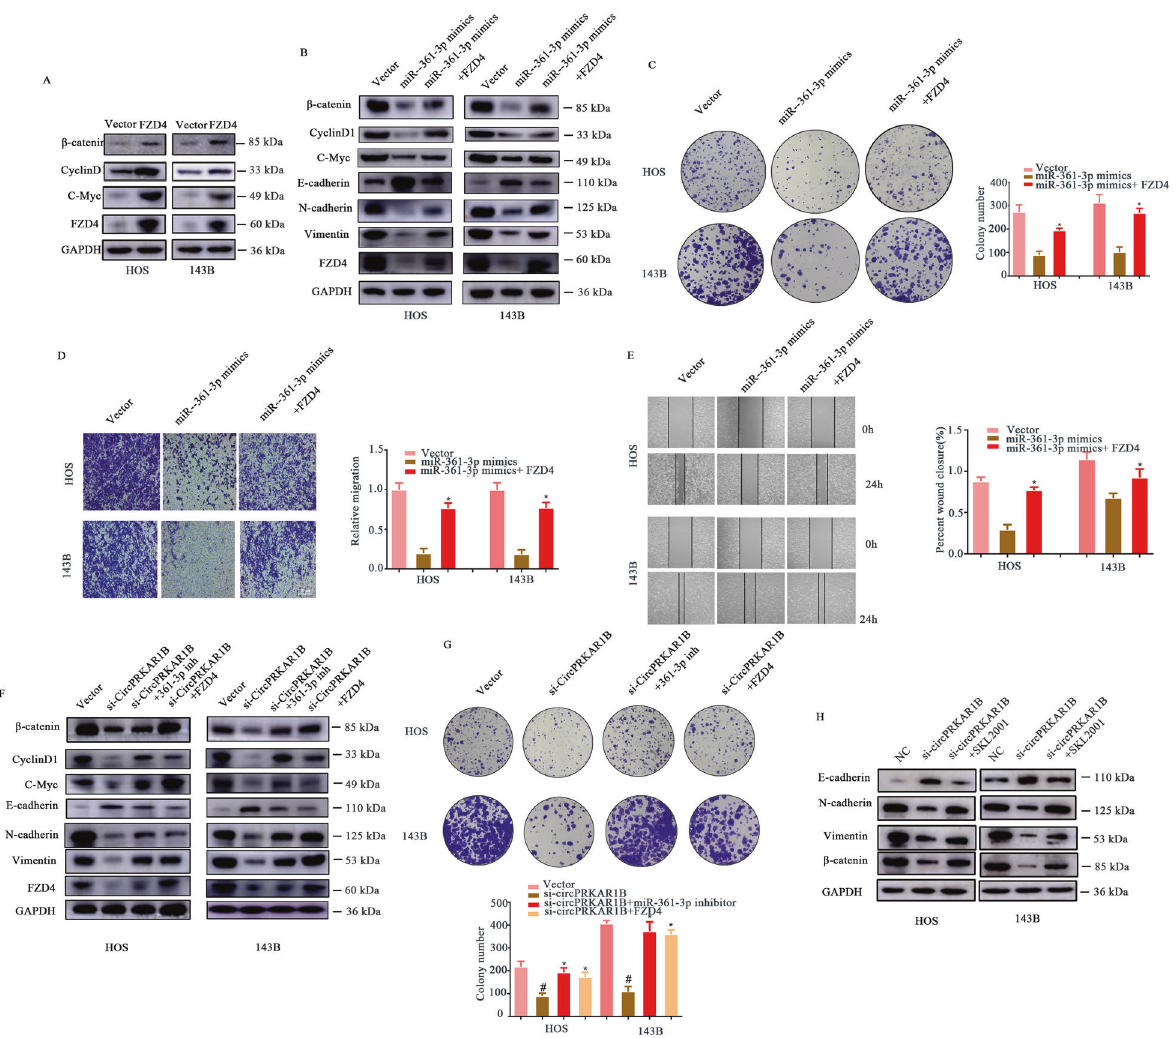
Fig. 5 circPRKAR1B promotes OS progression via the miR-361-3p/FZD4-Wnt/ β -catenin axis. A The protein levels of β -catenin, cyclin D1, C-myc and FZD4 in OS cells trasfected with FZD4 plasmid. B The protein levels of β -catenin, cyclin D1, C-myc, E-cadherin, N-cadherin, vimentin and FZD4 in OS cells transfected with miR-361-3p with or without FZD4 overexpression. C The reversal effect of FZD4 overexpression on the colony-forming ability of OS cells transfected with miR-361-3p mimics. D The enhancement of the migration ability of HOS and 143B cells was partially abrogated by co-transfection with any of the miR-361-3p mimics or FZD4 overexpression. E Representative images showing the reversal of migration ability upon FZD4 upregulation by the wound-healing assay. F WB revealed the reversal effect of the miR-361-3p inhibitor or FZD4 overexpression on EMT and the Wnt/ β -catenin signalling pathway in OS cells with circPRKAR1B knockdown. G The colony formation assay showed changes in the proliferation capacity of OS cells stably expressing si-circPRKAR1B transfected with or without the miR-361-3p inhibitor or FZD4 overexpression plasmid. H WB revealed the rescue effect of the β -catenin agonist (SKL2001) on EMT in OS cells with si-circPRKAR1B. The data represent the mean ± SD ( n = 3) (* P <